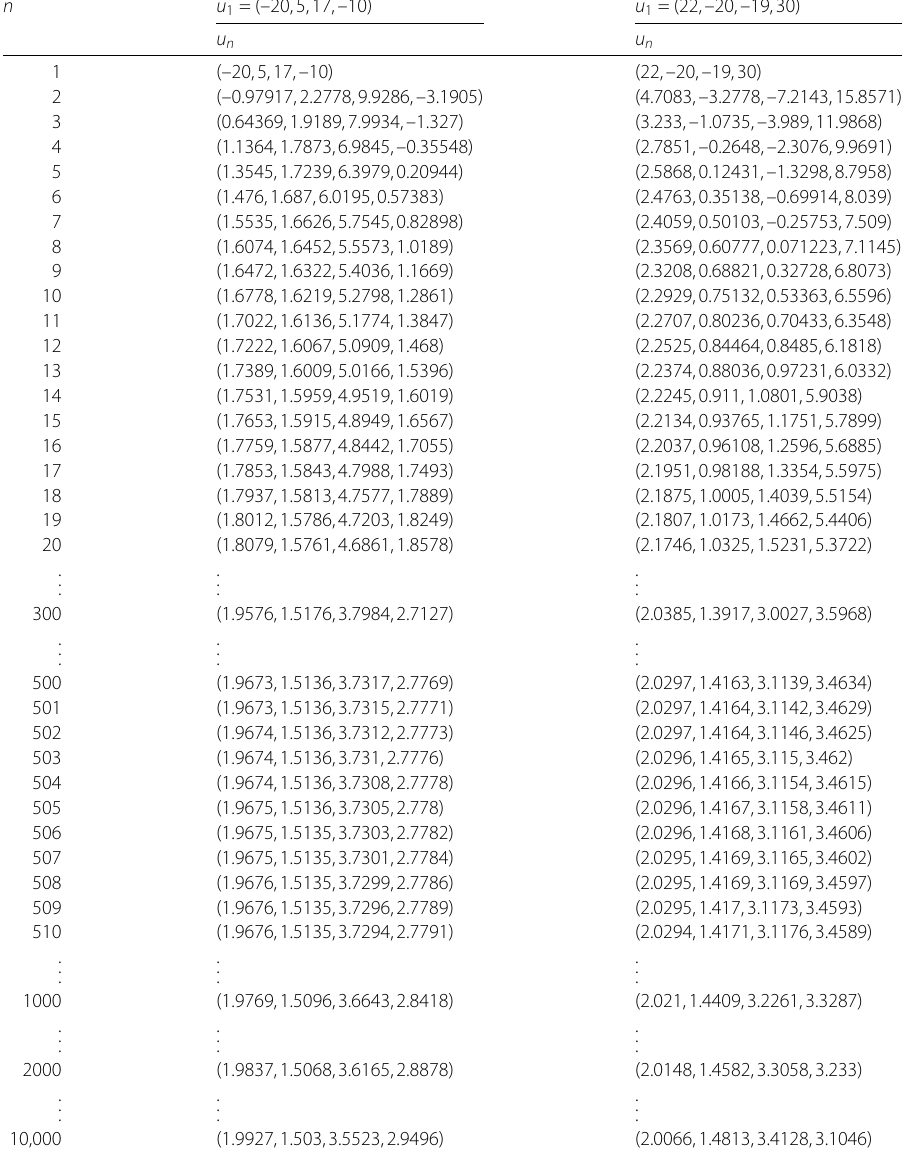
Table 2 Some values of { u n } from Example 4.2 with starting points of Case 1 and Case 2